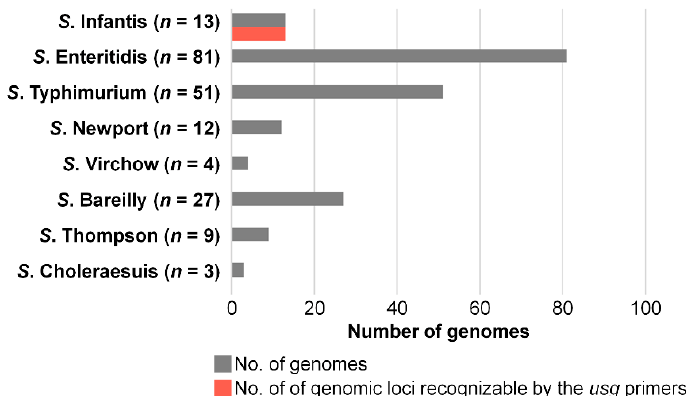
Figure 3. Evaluation of genotyping efficacy in silico. Genomic loci recognizable by the proposed diagnostic PCR primer set were counted in eight Salmonella serovars. The number of genomes analyzed in each serovar is shown in the gray bar, and the number of genomic loci that could be amplified by the diagnostic primers is shown in the red bar.